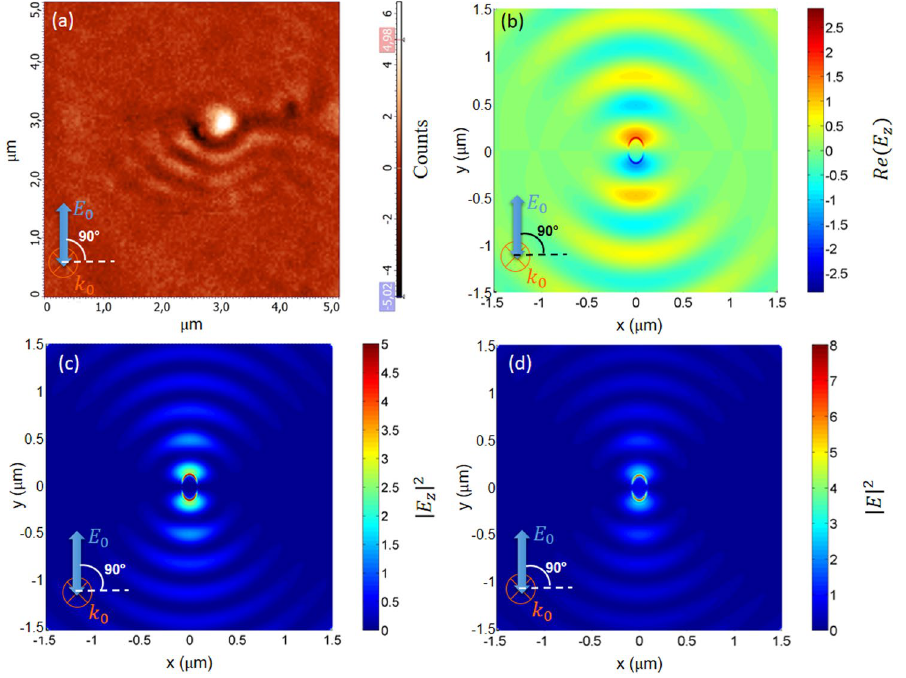
Figure 3. ( a ) SNOM image (scan area 5 μ m × 5 μ m) performed using an incident beam at λ exc = 632 nm with normal incidence and linear polarization at 90° on an elliptical nanohole in a thin gold film. The second polarizer is orthogonal respect to the first one (#1 ⊥ #2). Numerical results: ( b ) Near-field intensity distribution of Re ( E z ) around the elliptical nanohole illuminated by a plane wave at λ = 632 nm, at 2 nm from the metal surface. Simulations are performed by finite element method (FEM) simulation. Size of nanohole: major axis a = 130 nm, minor axis b = 80 nm. ( c ) Near-field intensity distribution of the z-component of the electric field E z 2 around the elliptical nanohole illuminated by a plane wave at λ exc = 632 nm, at 2 nm from the metal surface. ( d ) Near-field intensity distribution of the total electric field E 2 around the elliptical nanohole illuminated by a plane wave at λ exc = 632 nm, at 2 nm from the metal